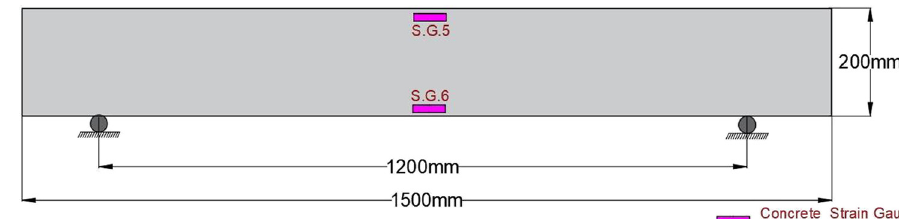
Figure 5: Locations of the concrete strain gauge.